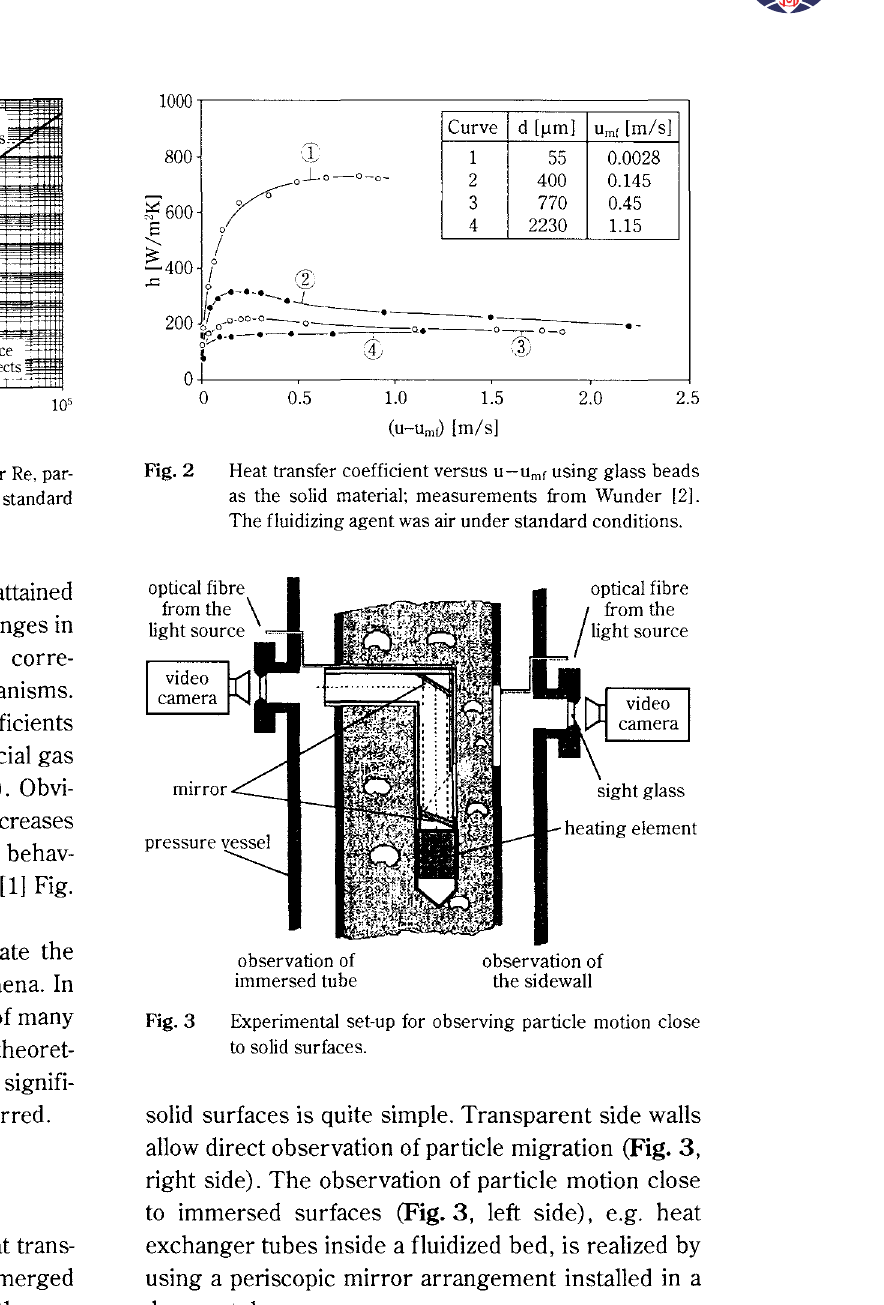
Fig. 1 Archimedes number Ar versus Reynolds number Re, par ticle sizes represent glass spheres in air under standard conditions